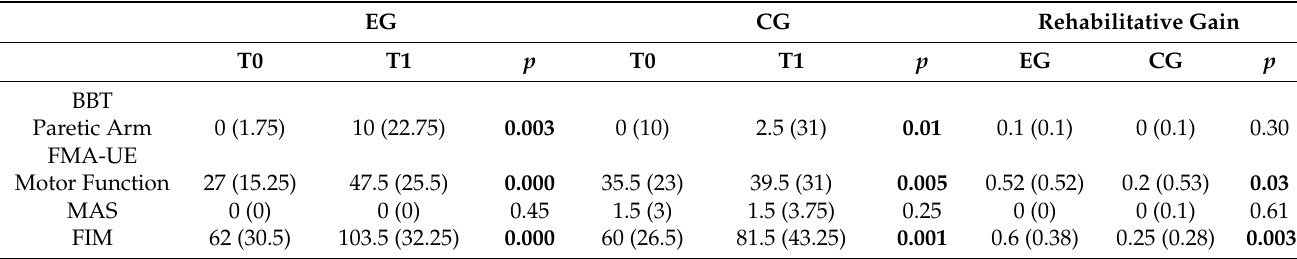
Table 2. Median, interquartile range (IQR), and significance of pre-treatment and post-treatment scores and of rehabilitative gain in the experimental group and in the control group.